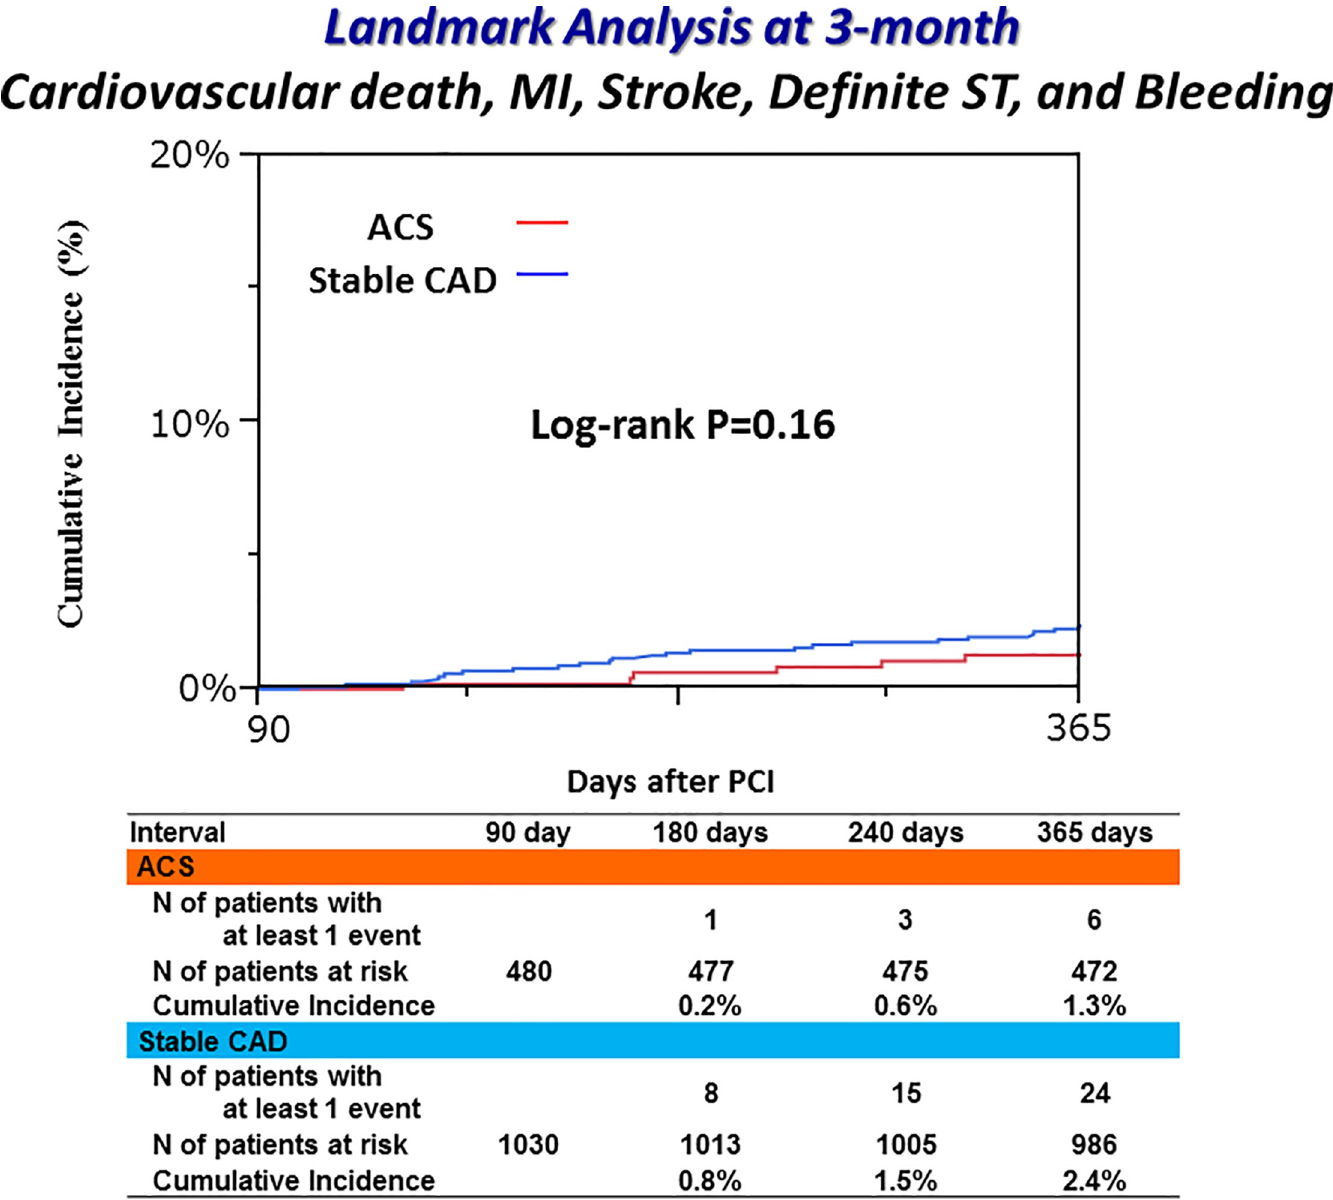
Fig 5. Cumulative incidence of the primary endpoint between 3-month and 12-month. Primary endpoint was defined as a composite of cardiovascular death, MI, stroke, definite ST and TIMI major/minor bleeding.